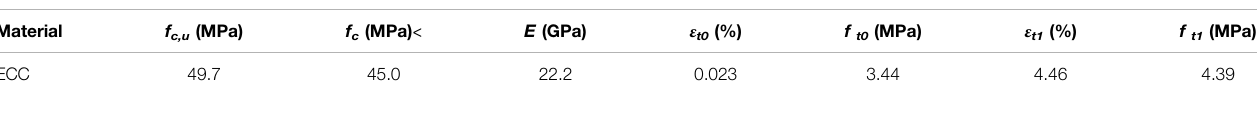
TABLE 3 | Mechanical properties of